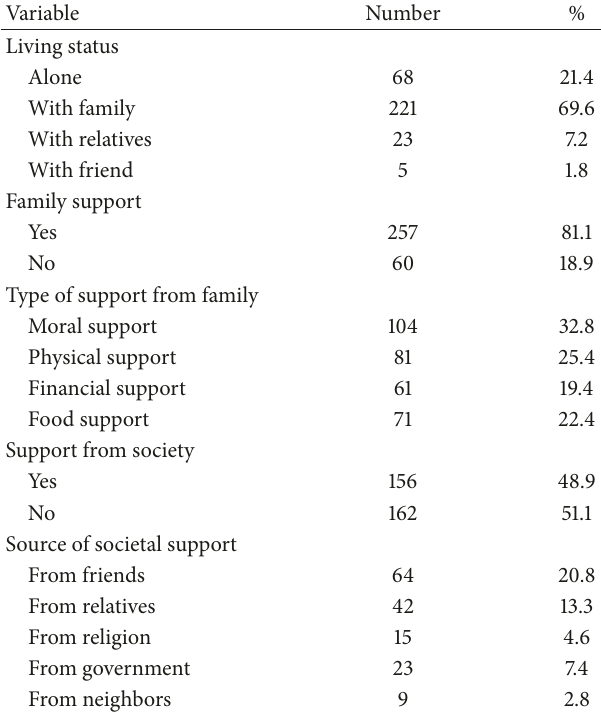
Table 1: Sociodemographic characteristics of study participants. Table 2: Social support characteristics of